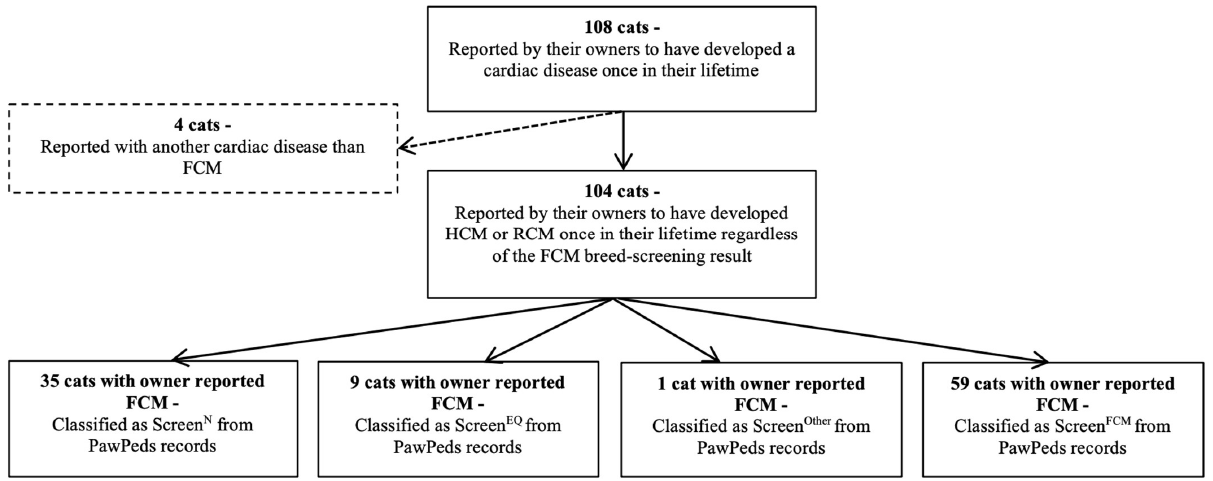
Figure 2. Flow chart describing development of cardiac disease at any time-point in the study pop- ulation. Screen N = Cats classified as normal at breed-screening, Screen EQ = Cats classified as equivo- cal at breed-screening, Screen FCM = Cats diagnosed with HCM or RCM at breed-screening, Screen Other = Cats classified as Other at breed-screening.